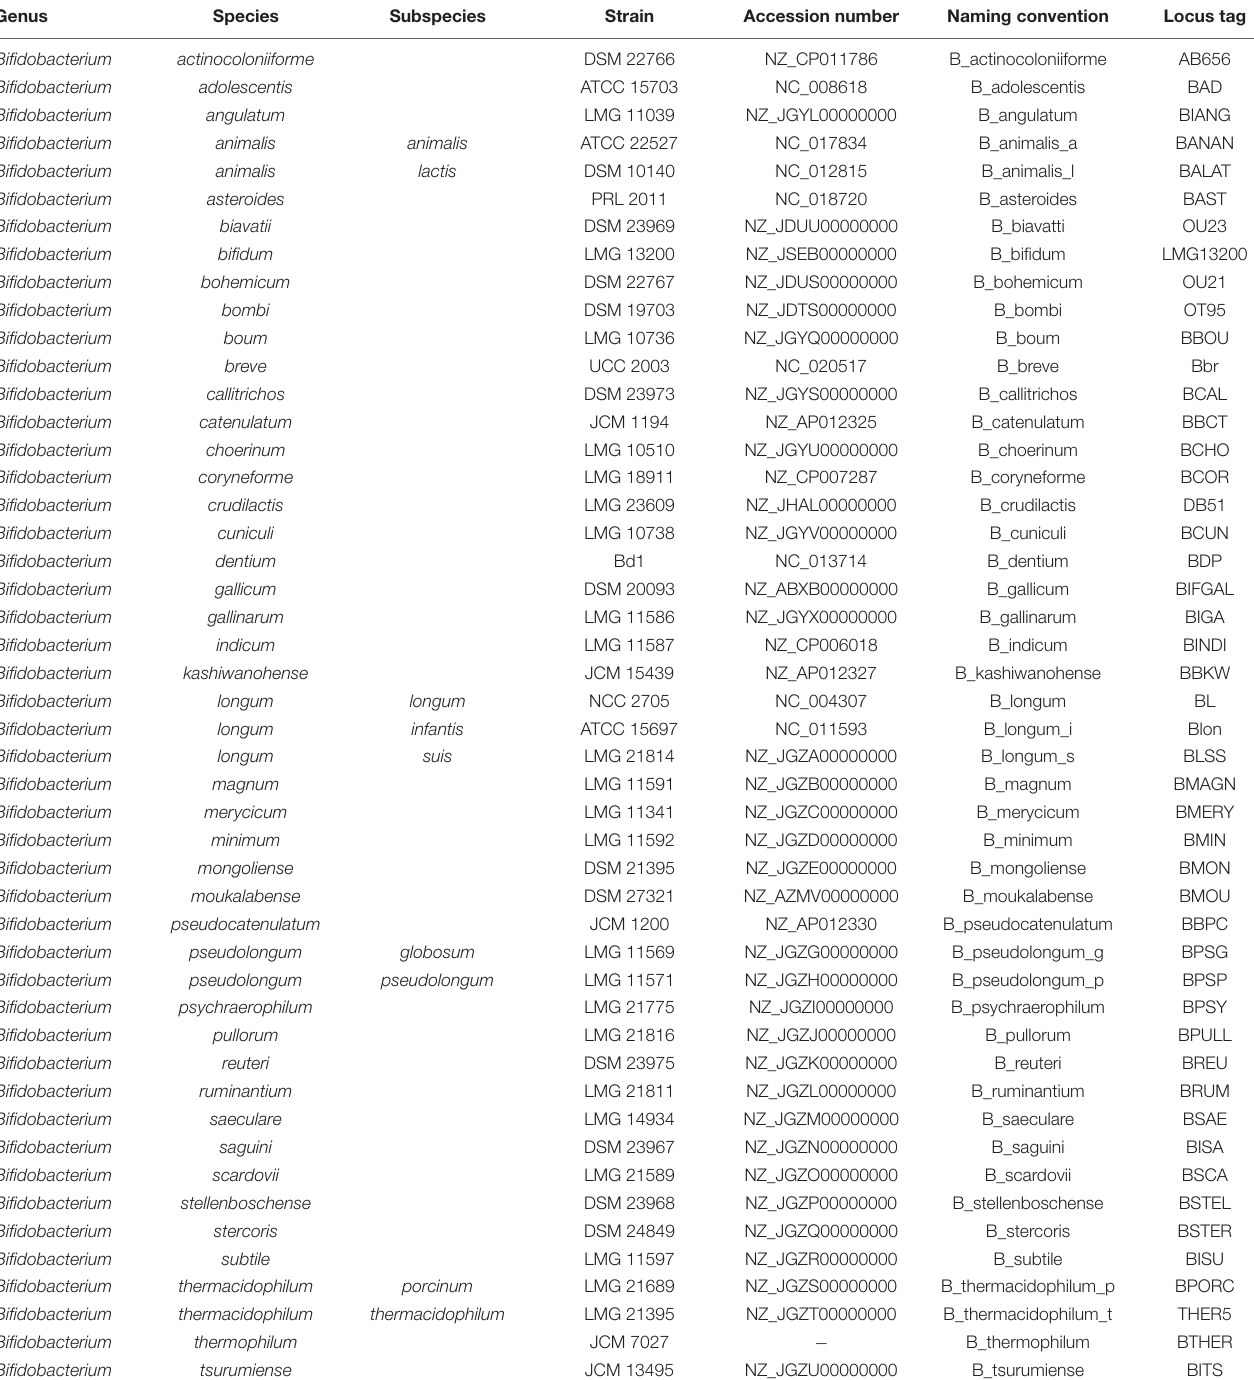
TABLE 1 | Species and genome